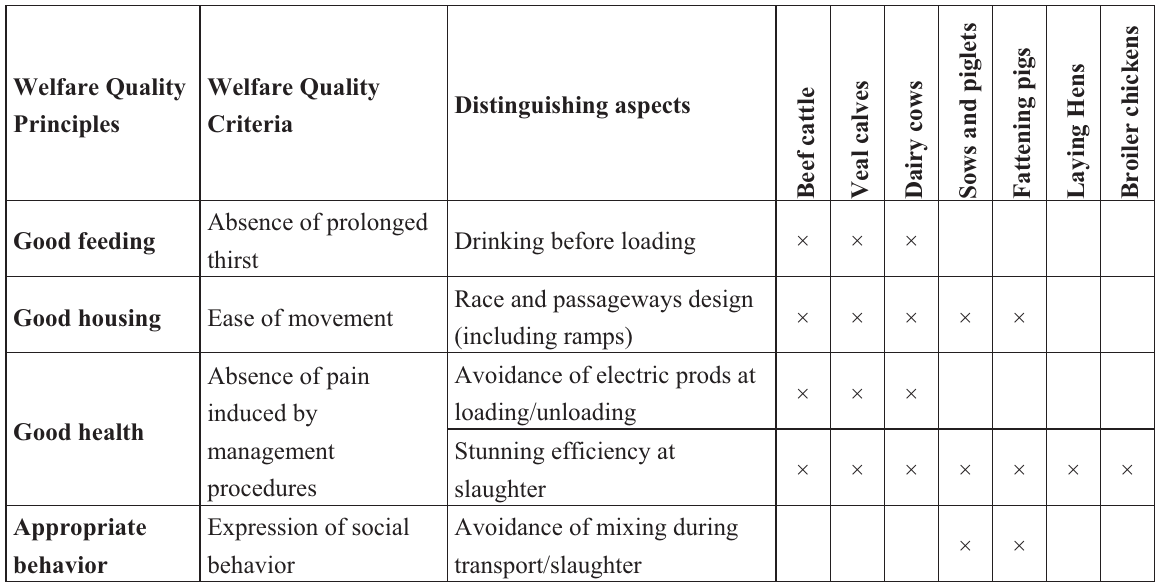
Table 3. Transport and slaughter aspects included in the different standards and initiatives considered as relevant for animal welfare by the consulted animal welfare scientists (source: